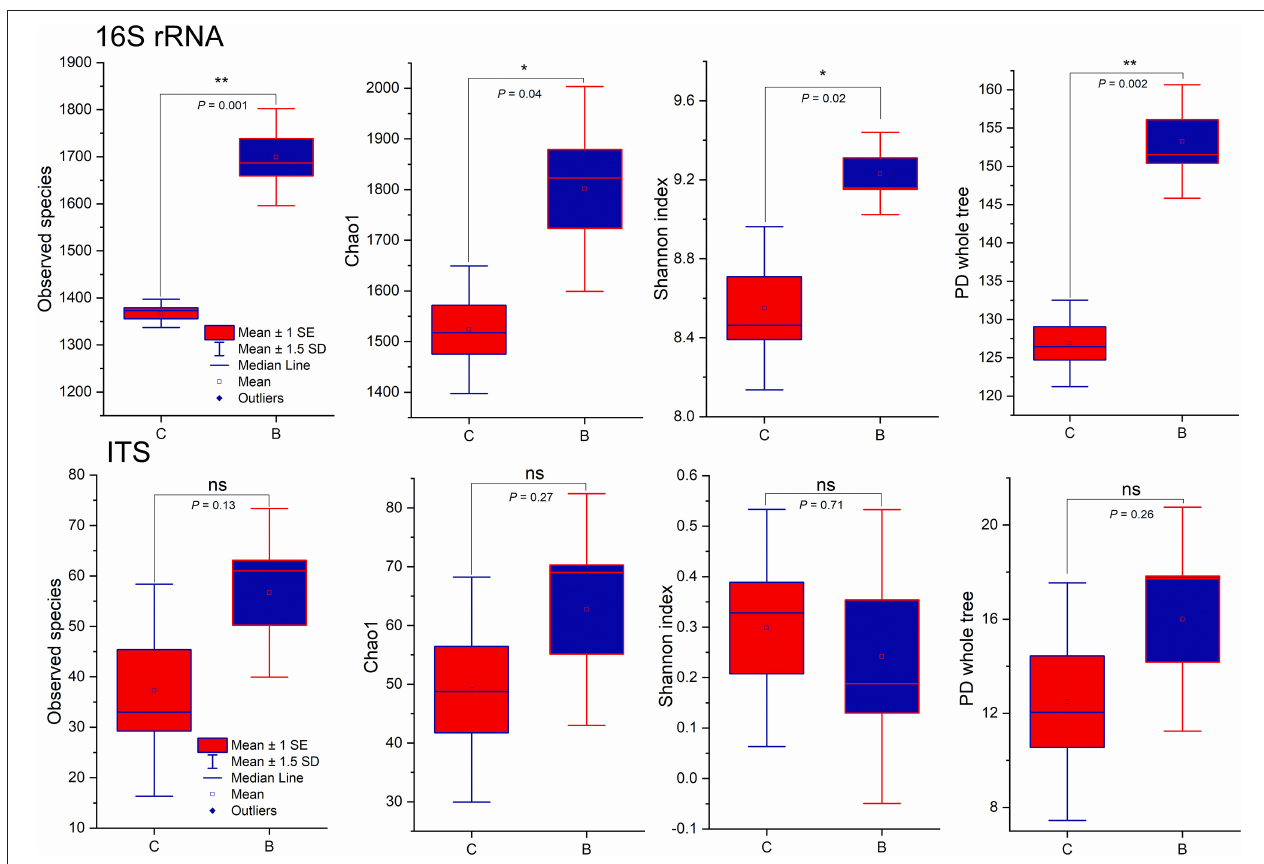
FIGURE 2 | Alpha diversity of the microbial community associated with rhizospheric soil. Column pairs marked with an asterisk indicate significant differences between the means according to the DMRT test ( P < 0.05*, P < 0.01**) B: Intercrop, C: Monoculture.